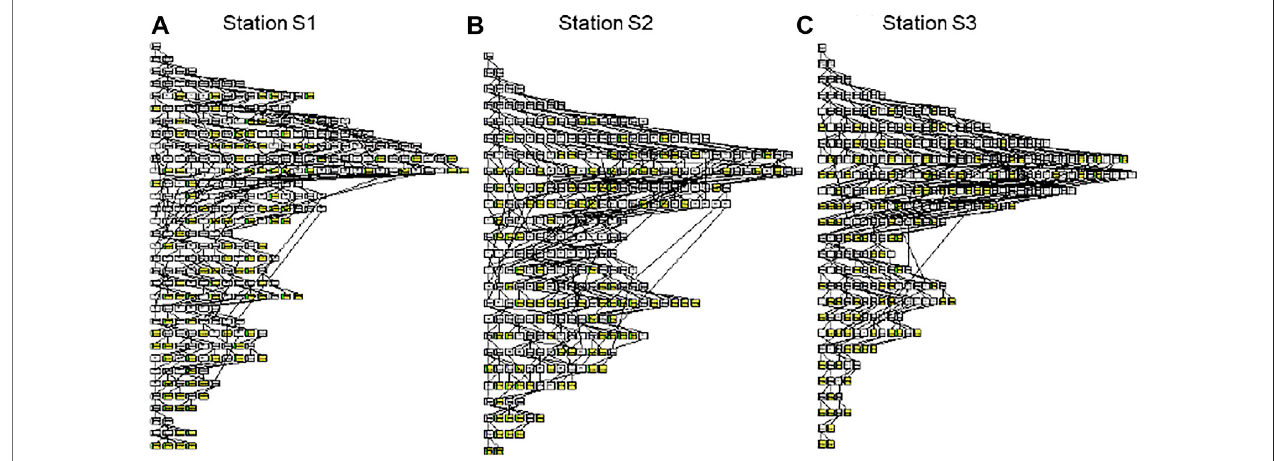
FIGURE4| SCAHmodelclustertreefor (A) StationS1, (B) StationS2,and (C) StationS3.(p (cid:2) 0.05andyellowboxesindicateendnodes;StationsS1,S2,andS3 represent Yichang station, Hankou station, and Datong station).